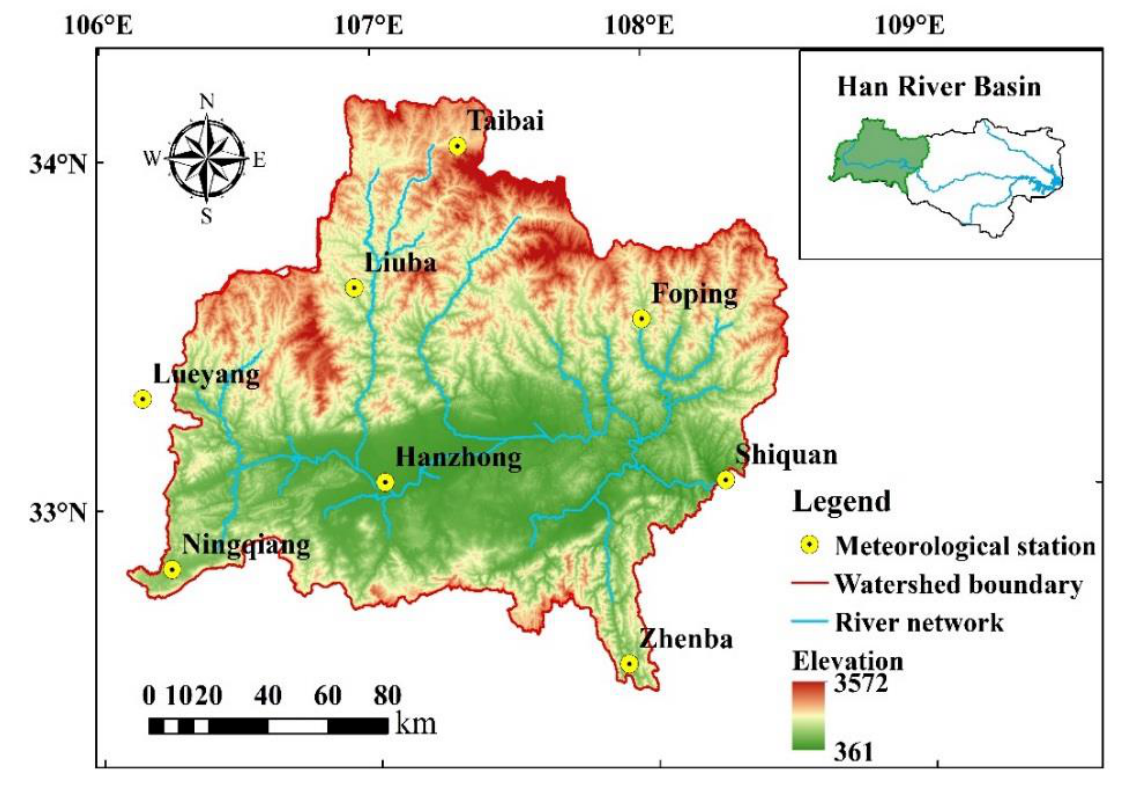
Figure 1. The study area.